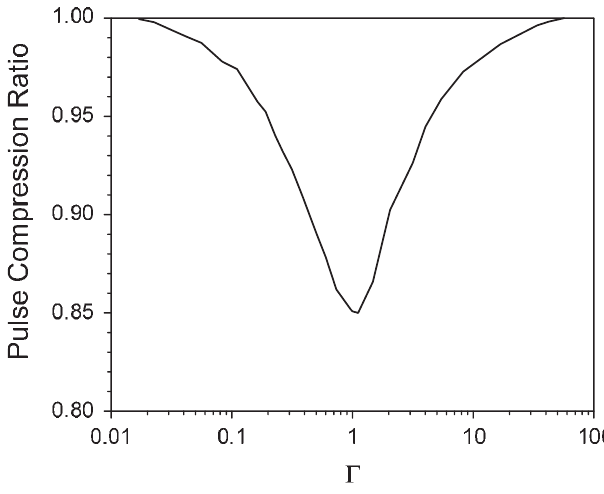
FIG. 6. (Color) Normalized planar-transmission-line gap pro- files for design II for several values of the profile parameter m ). (in steps of 1 2